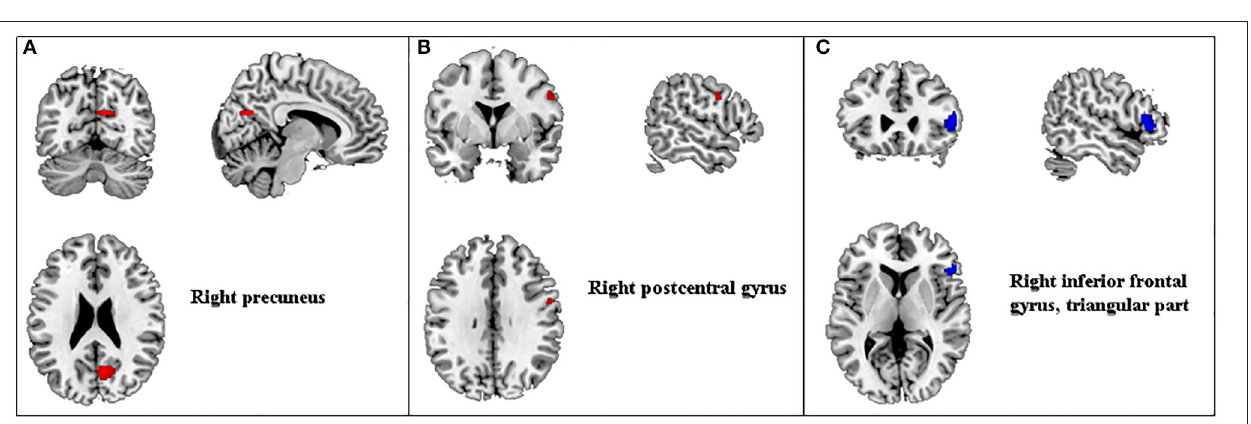
FIGURE 2 | Regions of ALFF differences before and after acupuncture treatment in patients with depression. Red for increased ALFF (A,B) and blue for decreased ALFF (C) . ALFF, amplitude of low-frequency